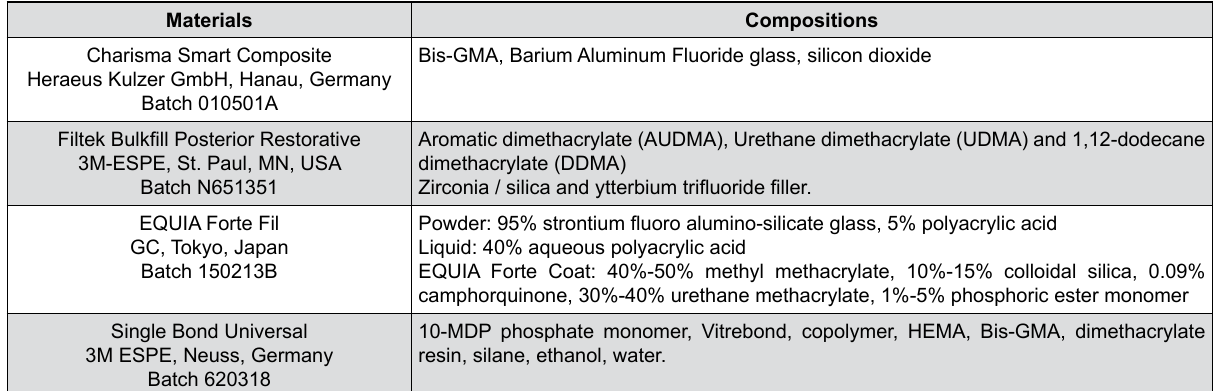
Figure 1- Materials, compositions and batch numbers